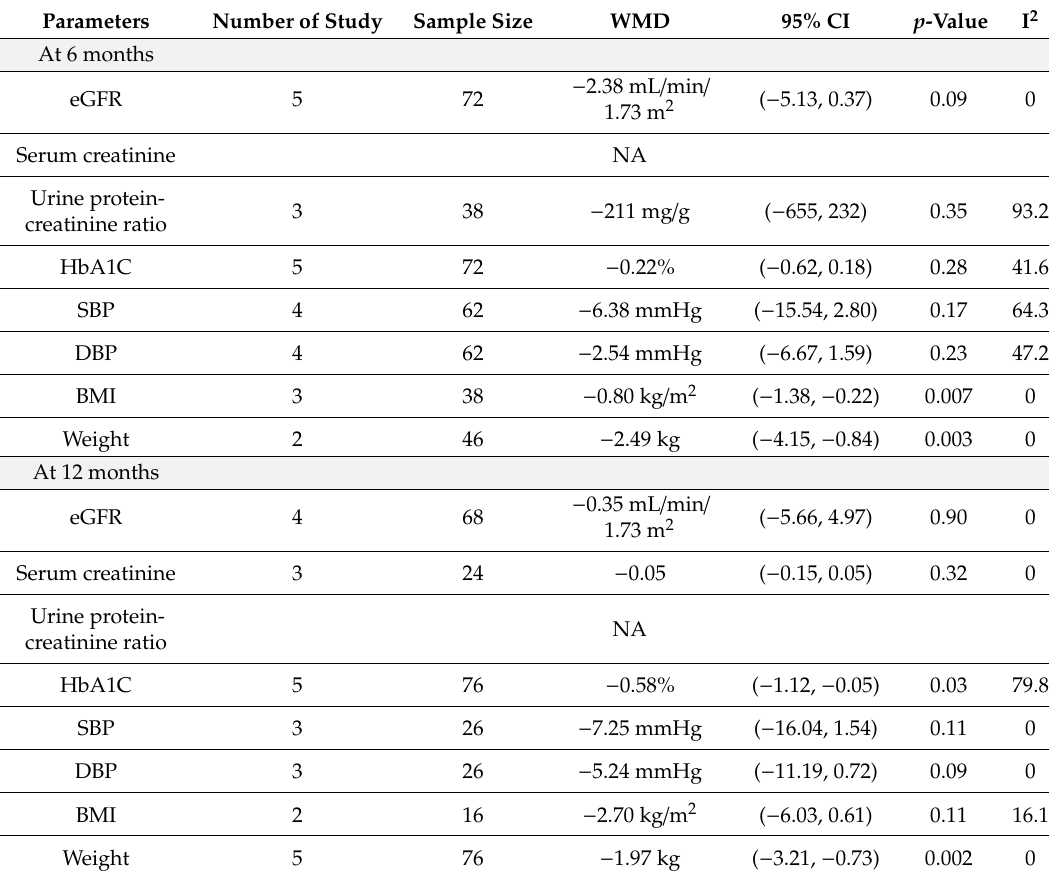
Table 3. Summary e ff ects of SGLT-2 inhibit ors on outcomes of interest among kidney transplant recipients with post-transplant diabetes mellitus, comparing levels at baseline and 6 months, 12 months, and subgroup analysis on types of SGLT-2